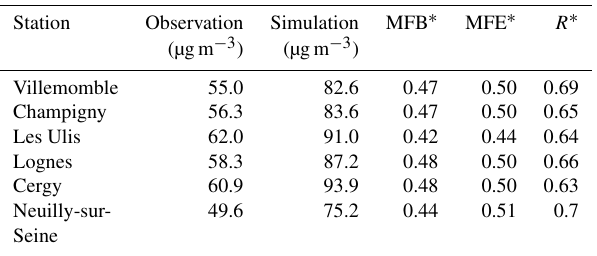
Table B2. Statistical indicators of the comparison of simulated hourly concentrations of O 3 to the concentrations measured at the urban background air monitoring stations within domain 3 (see Fig. 4).